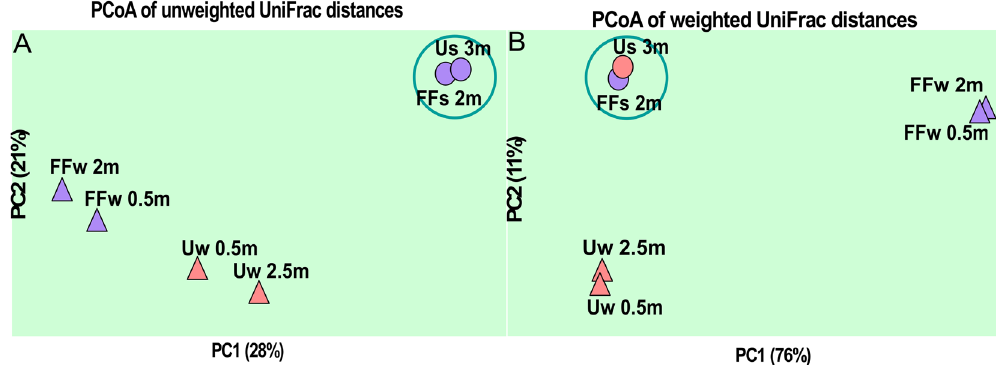
Figure 1. PCoA analyses of prokaryotic communities found in the water columns (triangles) and sapropels (circles) of Ursu and Fara Fund lakes, generated by using both unweighted ( A ) and weighted ( B ) UniFrac distance matrices. The water column sequences were recovered from SRA (accession numbers: SRS691458, SRS691457, SRS691436 and SRS691388). Abbreviations: Us3m – Ursu Lake sapropel sample from 3 m depth; FFs2m – Fara Fund Lake sapropel sample from 2 m depth; Uw0.5 m and Uw2.5 m – Ursu Lake water samples from 0.5 m and 2.5 m depths; FFw0.5 m and FFw2m – Fara Fund Lake water samples from 0.5 and 2 m